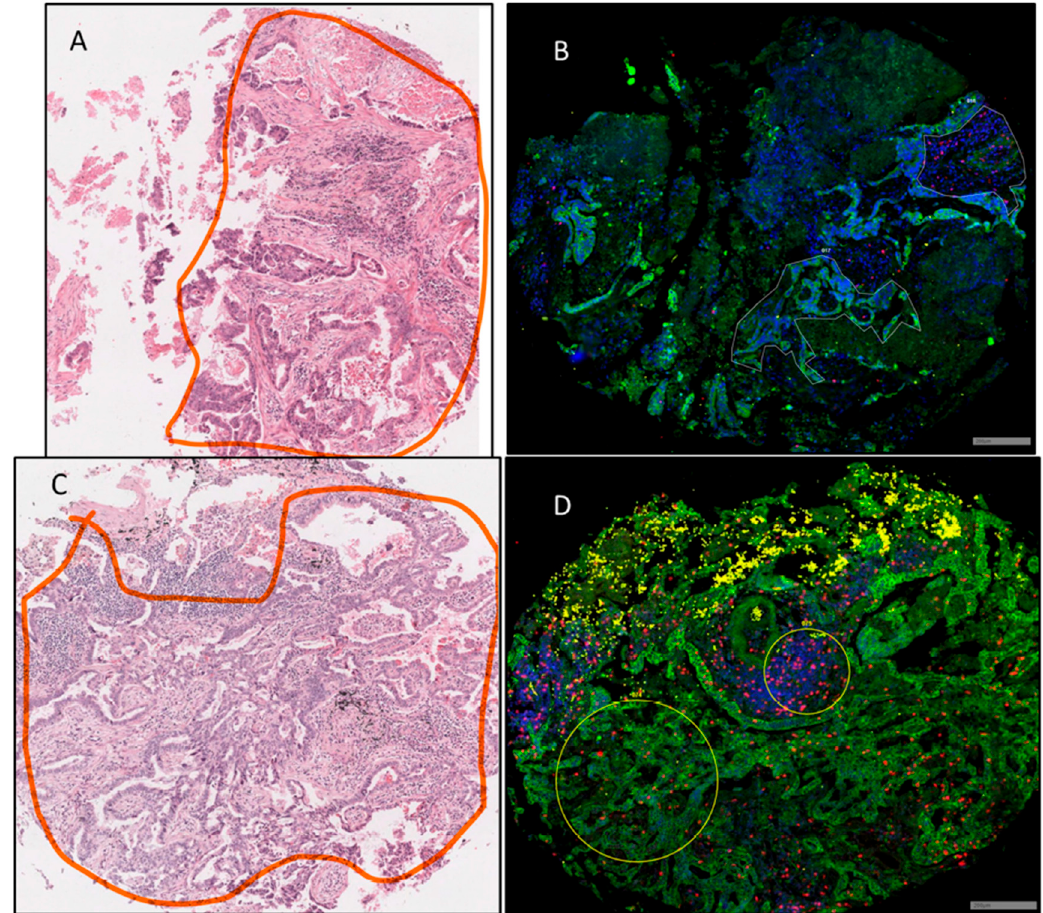
Figure 1. Representative H&E and immunofluorescent images of TMA cores. ( A , C ) Tumour regions of the cores were demarcated by a pathologist. ( B , D ) Corresponding regions of interest (ROIs) were captured for DSP analysis based on immunofluorescent staining for PanCK (Green), CD3 (Red), CD45 (Yellow), and DAPI (Blue). Tumour ROI (lower left) and tumour microenvironment (TME) ROI (upper right) were manually drawn in ( B ), and a circular tumour ROI (lower left) and TME ROI (upper right) are used in ( D ). Scale bar not available for H&E images, as images obtained from commercial supplier and are representative only. Scale bar = 200 µm.